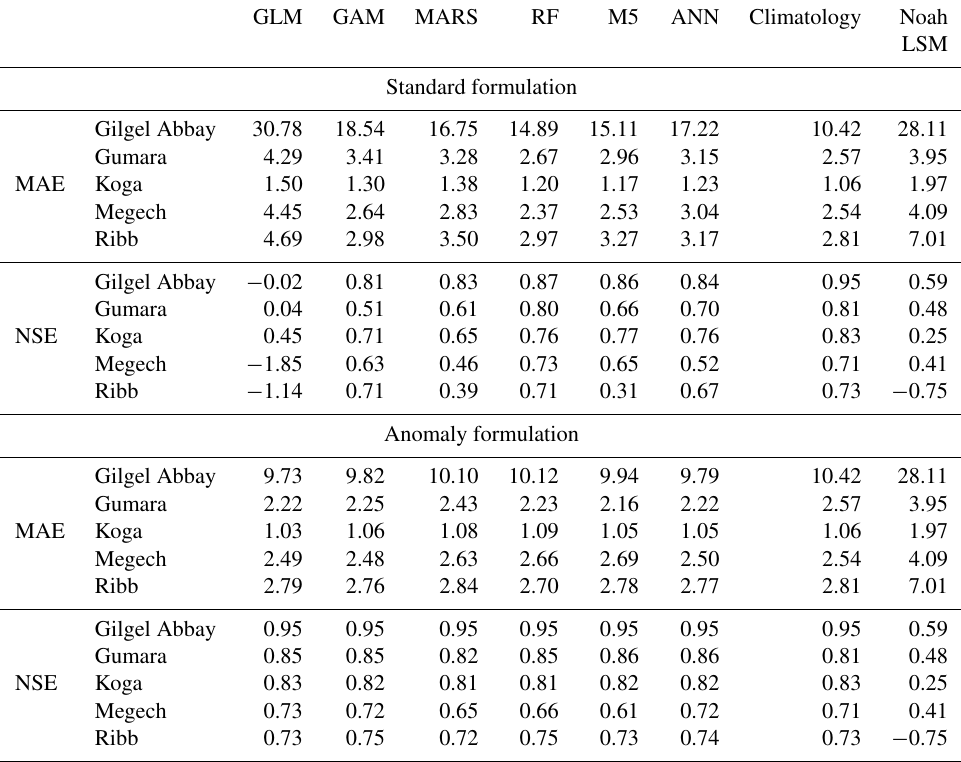
Table 3. Cross-validation errors for each assessed